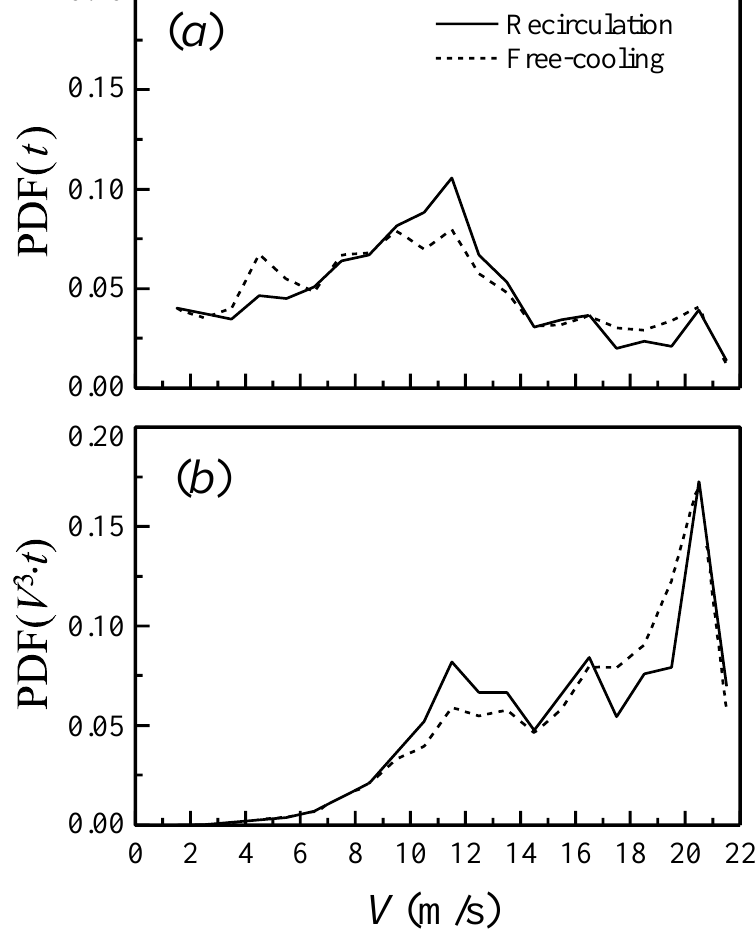
Figure 5. Probability density functions PDF of ( a ) t and ( b ) V 3 · t at various train speed V .